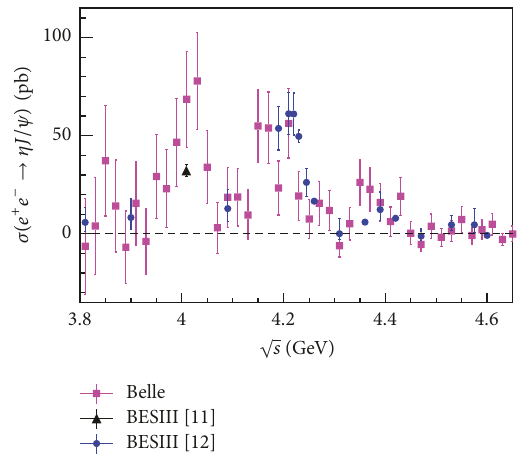
Figure 1: Cross section of 𝑒 + 𝑒 − → 𝜂𝐽/𝜓 from BESIII and Belle experiments.